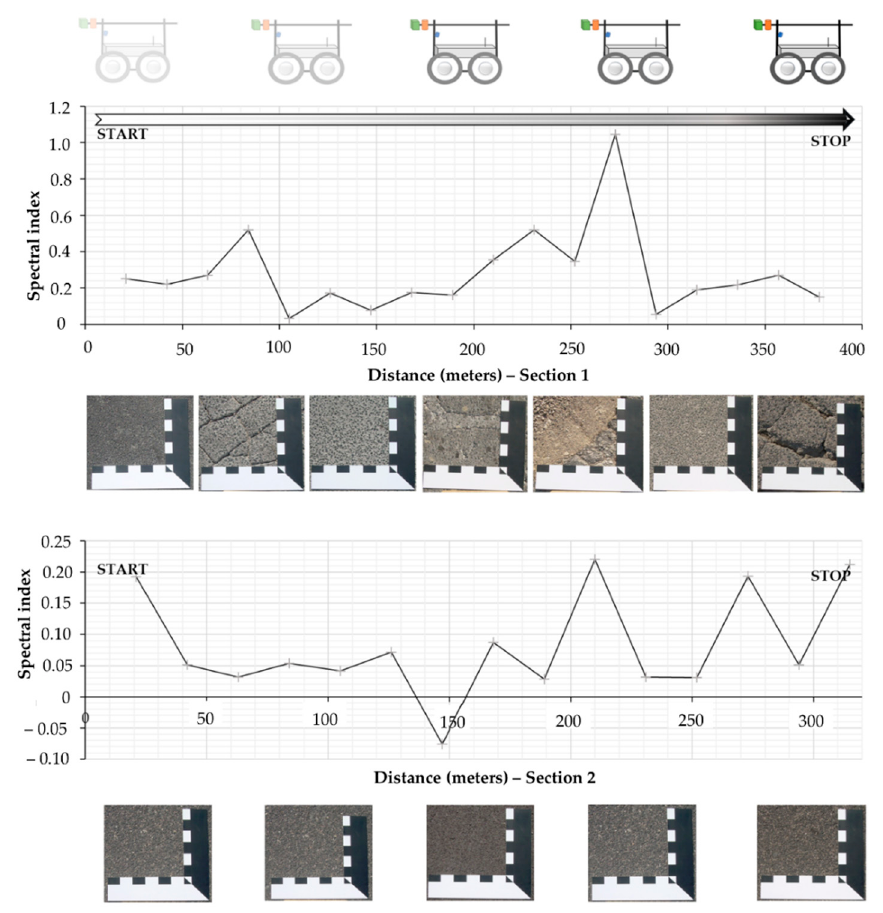
Figure 7. Spectral index variation during rover crossing.